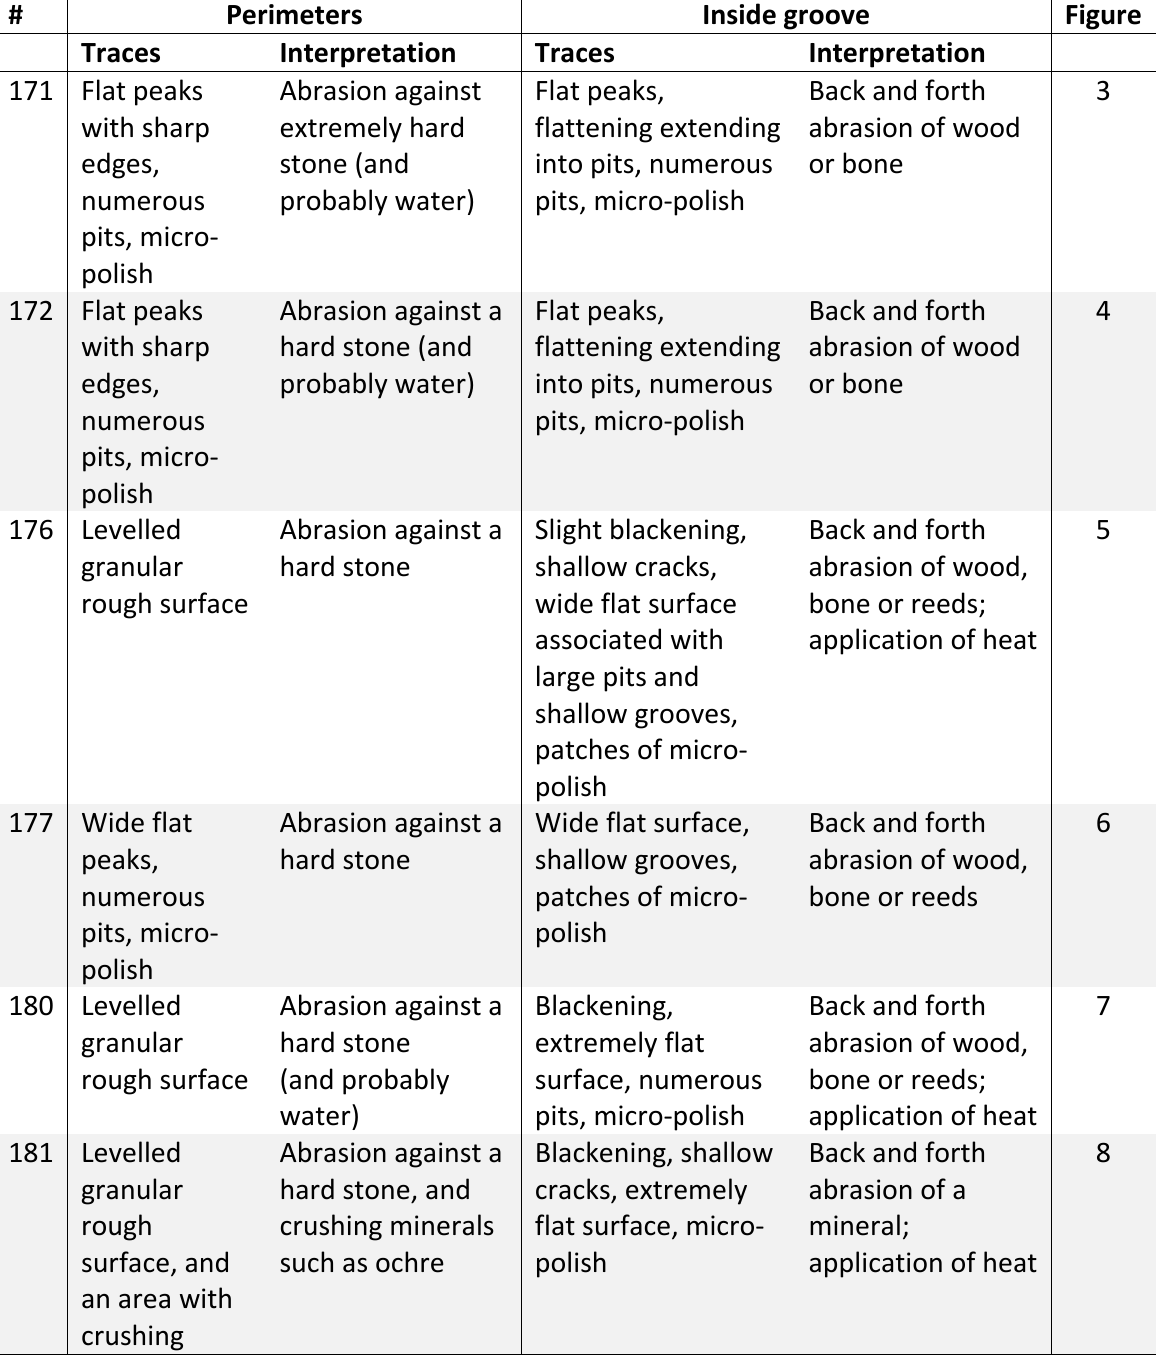
Table 2: Summary of use-wear analysis results with details of the wear characteristics and the inferred